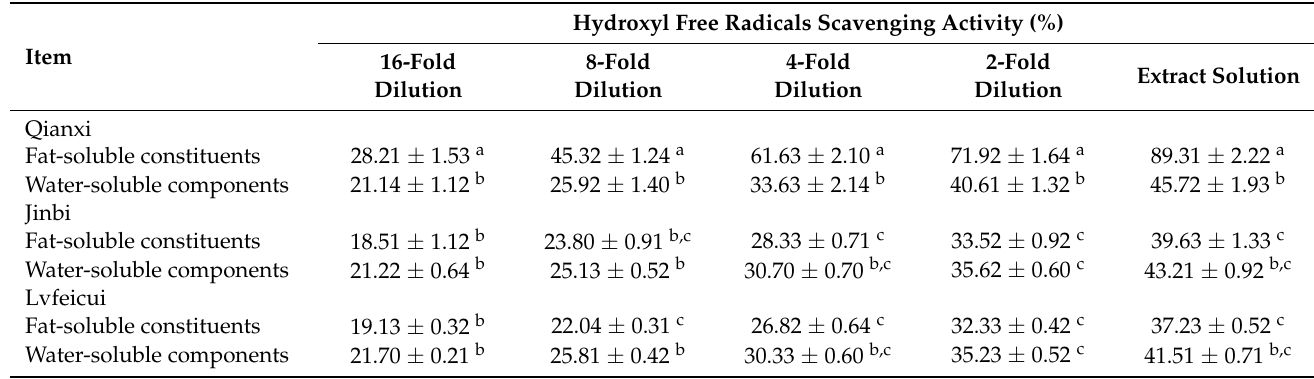
Table 5. Hydroxyl free radicals scavenging activity of three different cherry tomato